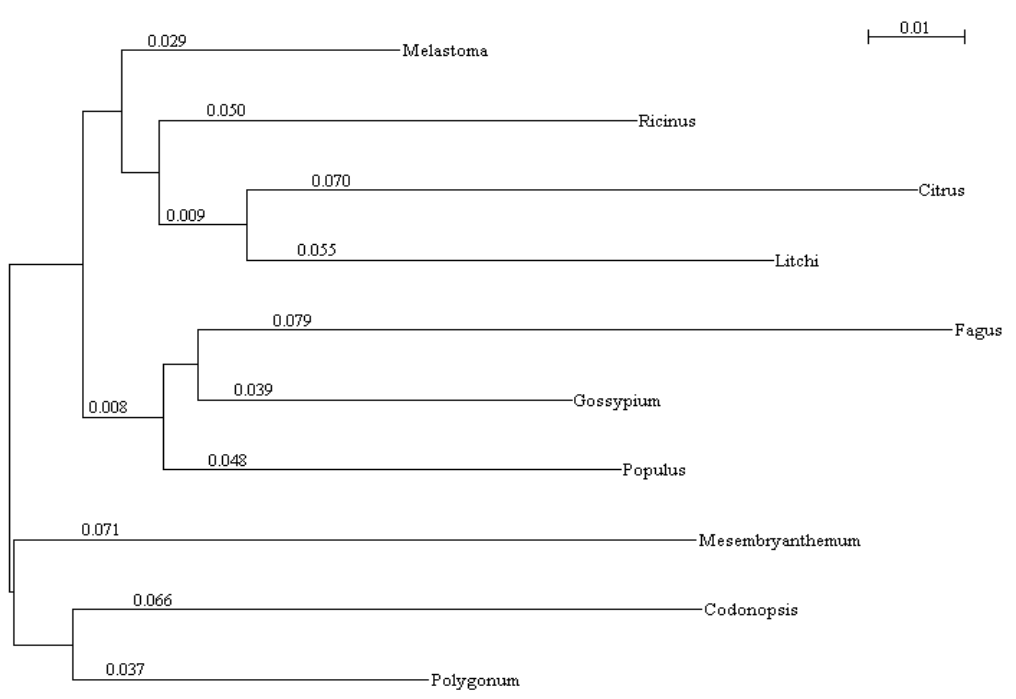
Figure 3. The phylogenetic tree of PS-CuZnSOD from plants and animals. Clustal W was used to establish the phylogenetic tree, and the result was displayed using Treeview